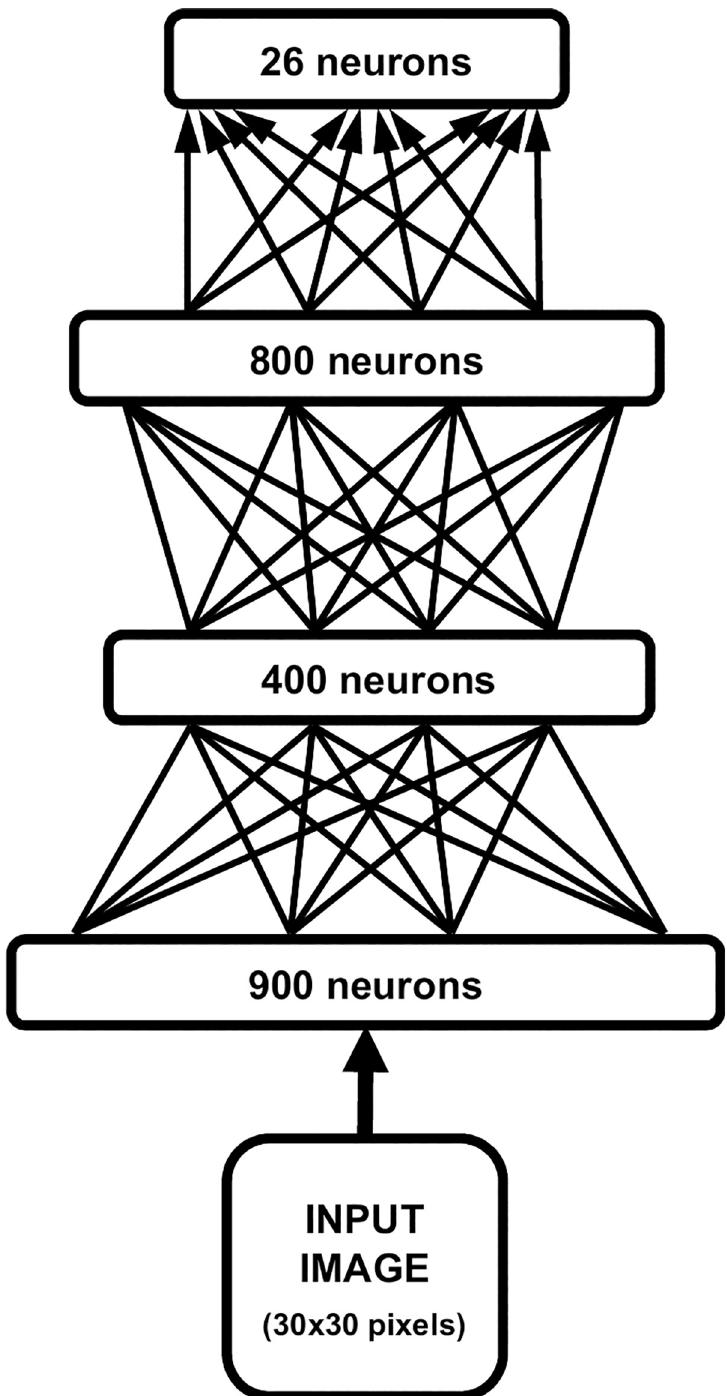
Fig 2. Architecture of the deep learning model. The input image was vectorised and presented through an input layer (900 neurons). Two hidden layers of 400 and 800 neurons, respectively, were then used to learn a hierarchical generative model in a completely unsupervised fashion (undirected arrows). The behavioural task is finally simulated by stacking a read-out classifier on top of the network (directed arrows).